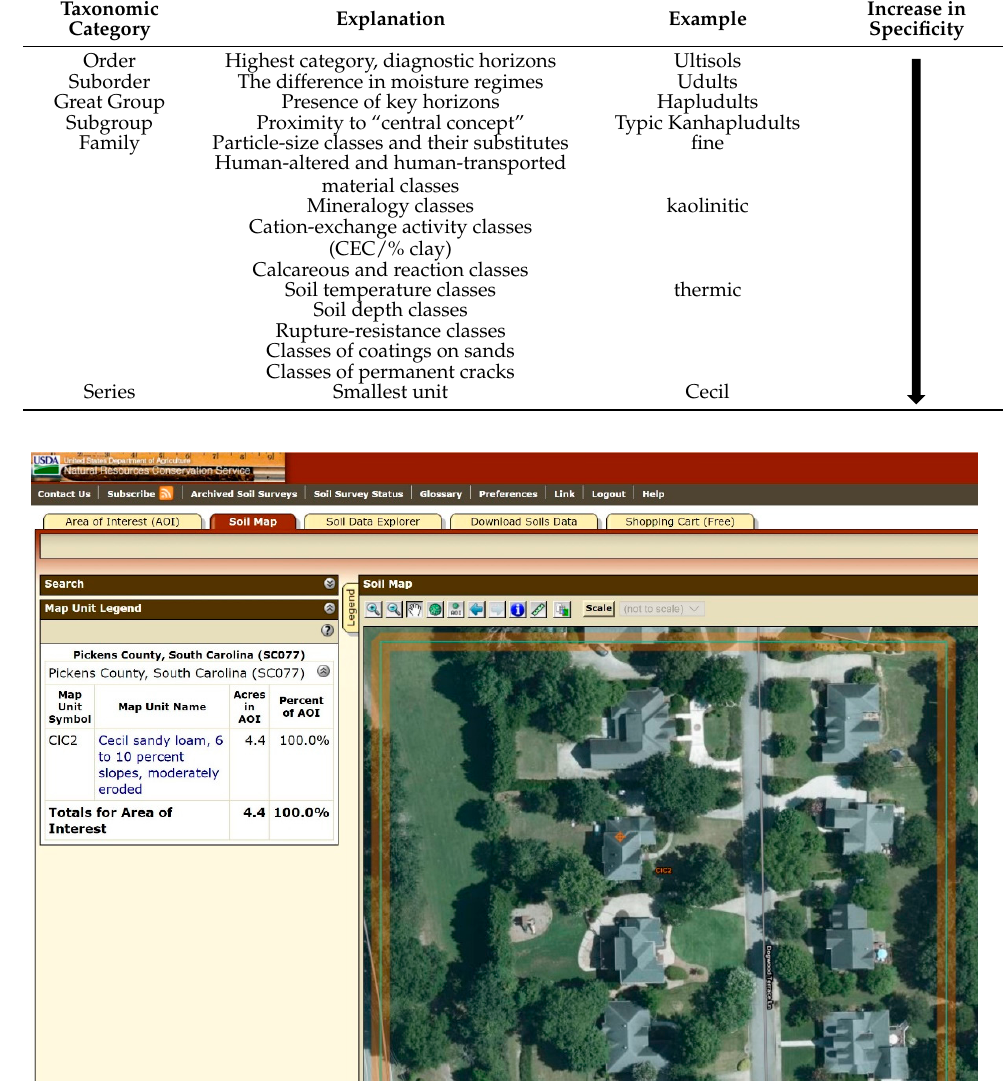
Table 4. Example of criteria and sequence of taxonomic categories used to classify soils.